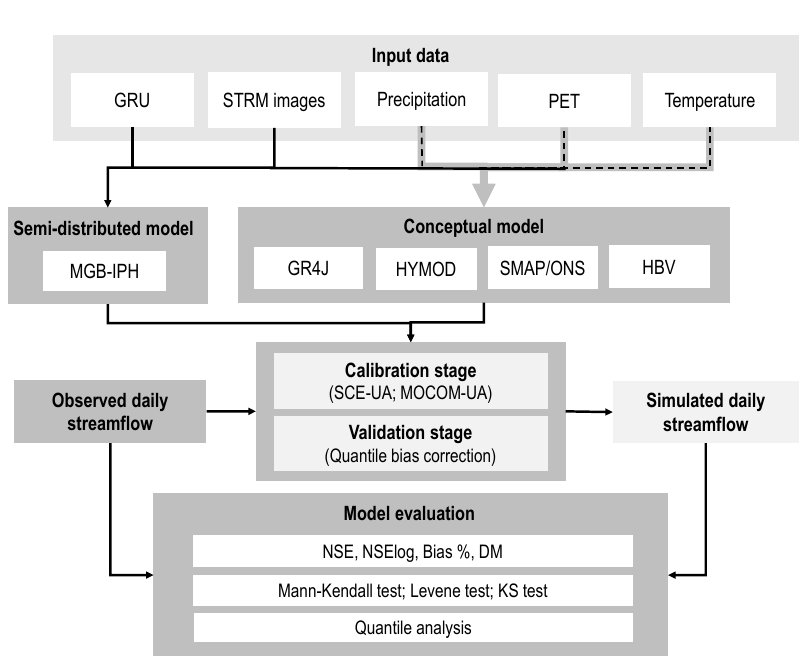
Figure 1. Flow chart of the hydrological modeling